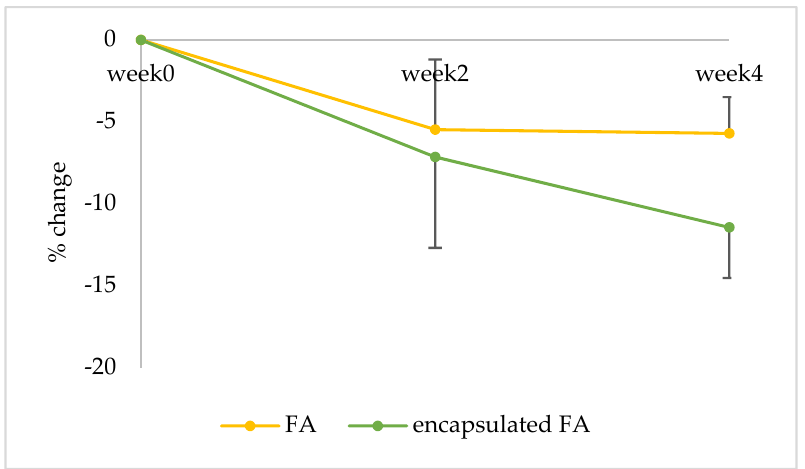
Figure 9. Percent of change in melanin of 16 volunteers after application of FA and encapsulated FA creams.